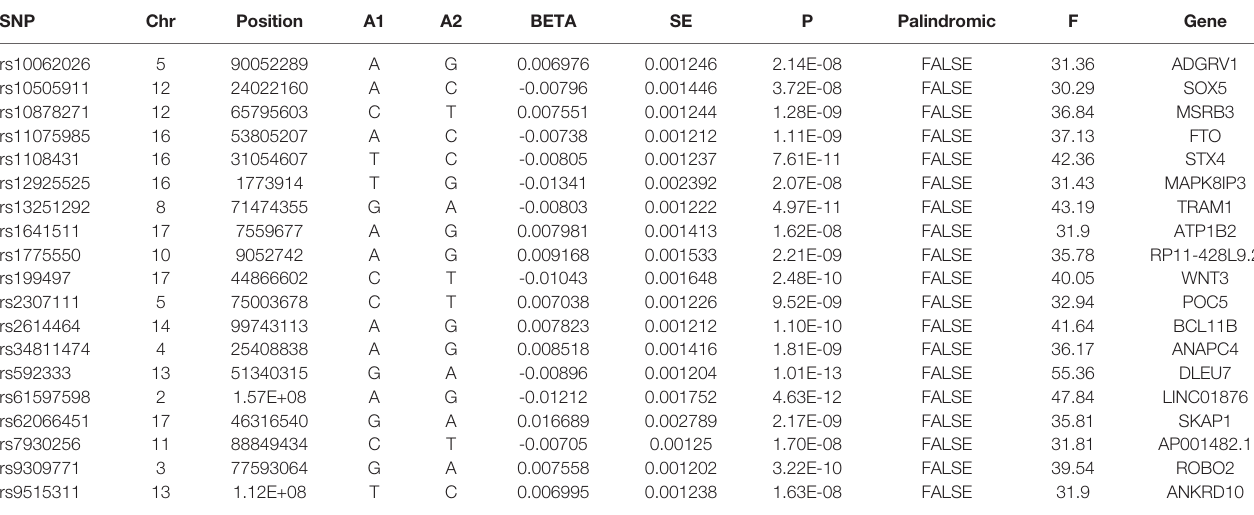
TABLE 1 | SNPs used as genetic instruments in the Mendelian randomization analyses. SNP Chr